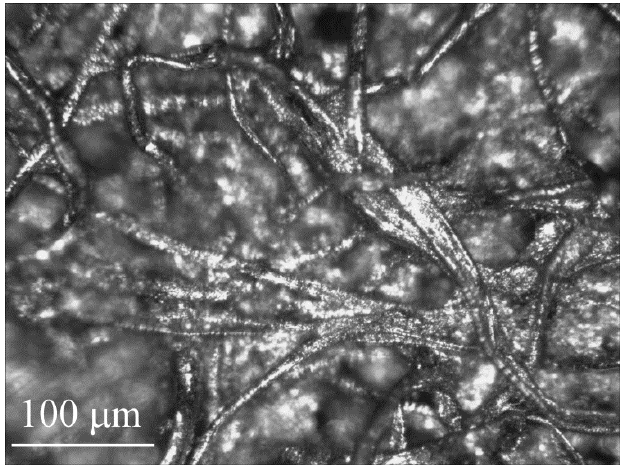
Figure 1. Micrograph of the surface of Whatman 2 filter paper, coated with platinum for enhanced contrast to permit visualization of the fiber structure.